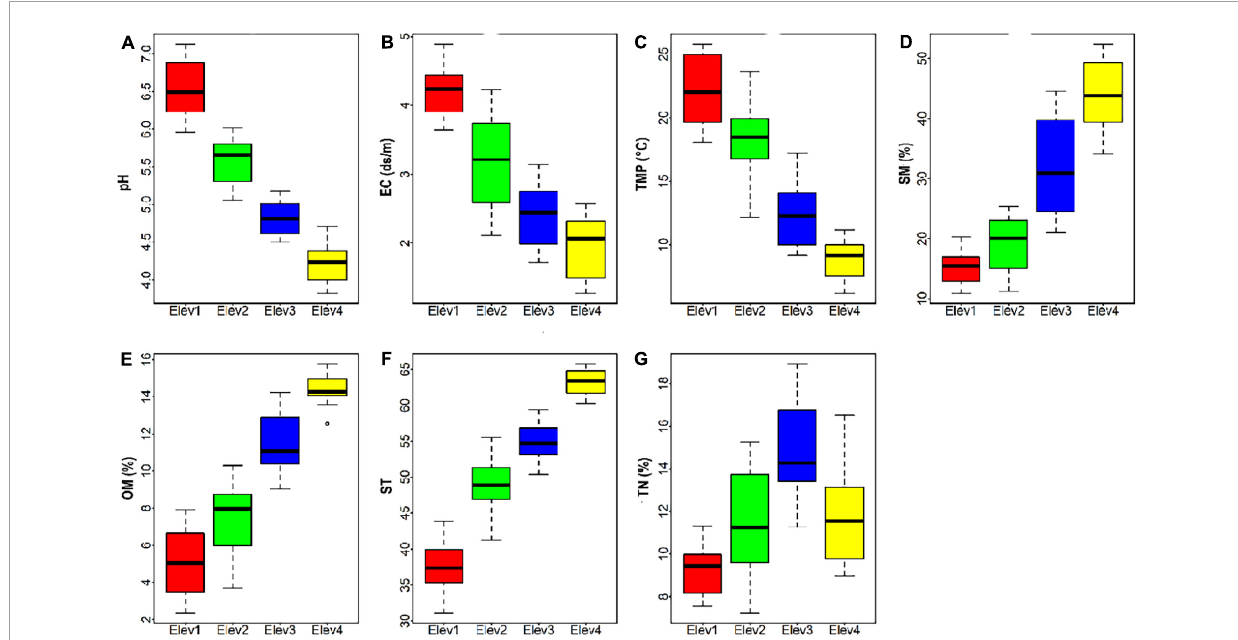
FIGURE1 Soil physico-chemical properties across elevation classes (A) pH, (B) EC, electrical conductivity, (C) TMP, temperature, (D) SM, soil moisture, (E) OM, organic matter, (F) ST, soil texture, and (G) TN, total nitrogen. Elev, Elevation; where Elev1: 1,000–1,400 m, Elev2: 1,401–1,800 m, Elev3: 1,801–2,200 m, and Elev4: 2,201–2,600 m.